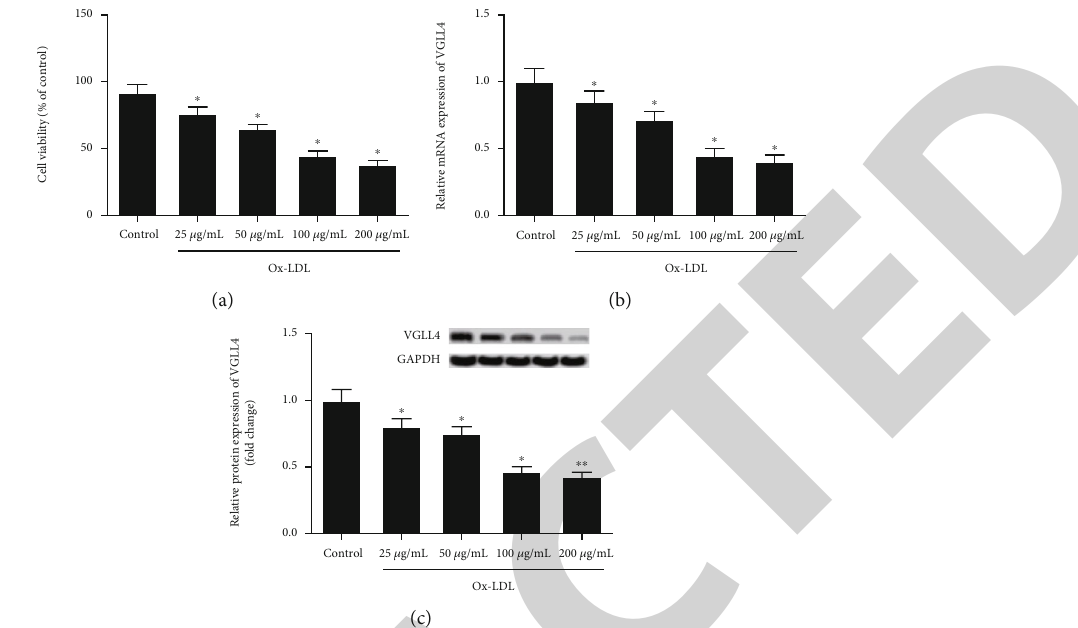
Figure 1: The expression of VGLL4 is lower in Ox-LDL-induced HUVECs. (a) The CCK-8 was used to detect cell viability of HUVECs. (b) The mRNA expression of VGLL4 in HUVECs treated with Ox-LDL at 25, 50, 100, and 200 μ g/mL. (c) The protein expression of VGLL4 in HUVECs cells treated with Ox-LDL at 25, 50, 100, and 200 μ g/mL. “ ∗ ” means compared with the control group at P < 0 : 05 . GAPDH was used as an invariant internal control for calculating protein fold